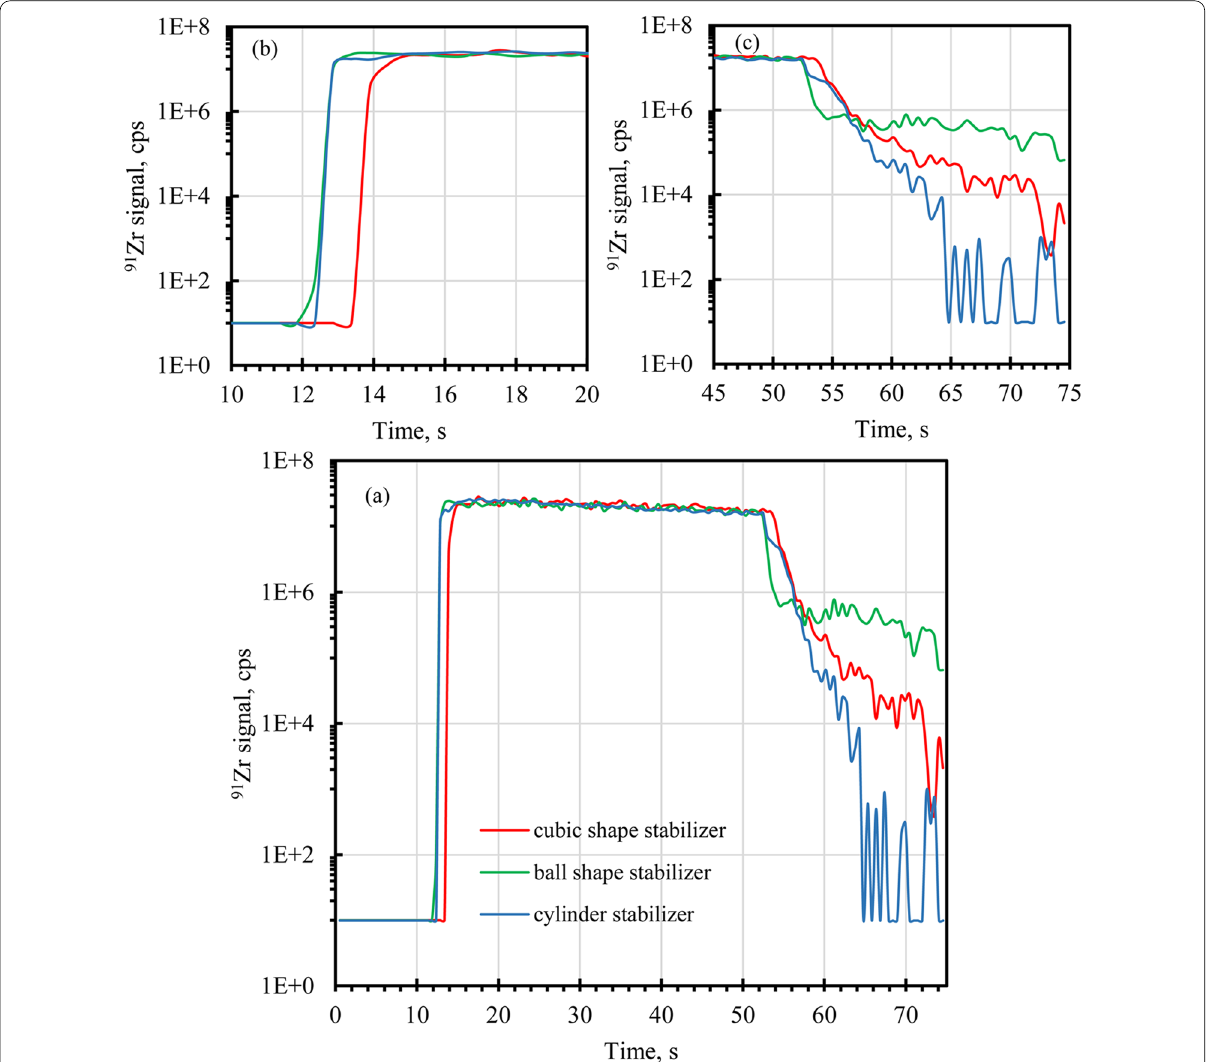
Fig. 3 Transient signal profiles of 91 Zr intensity of zircon standard 91500 with 35 μm of spot size and 5 Hz of laser repetition rate using stabilizers with different shapes. a Presented the signal profiles of 91 Zr versus assay time, while b , c Showed the signal rising and washout curves when using cylinder, cubic and ball shape stabilizers. The studied volumes for the cylinder, cubic and ball shape stabilizers were 21.2, 18.0 and 14.1 mL,